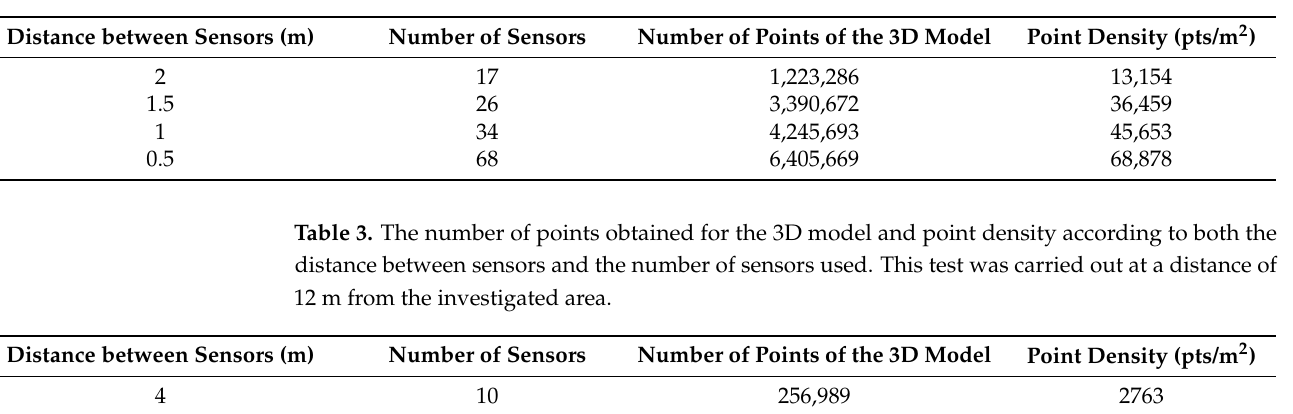
Table 2. The number of points obtained for the 3D model and point density according to both the distance between sensors and the number of sensors used. This test was carried out at a distance of 6 m from the investigated area.